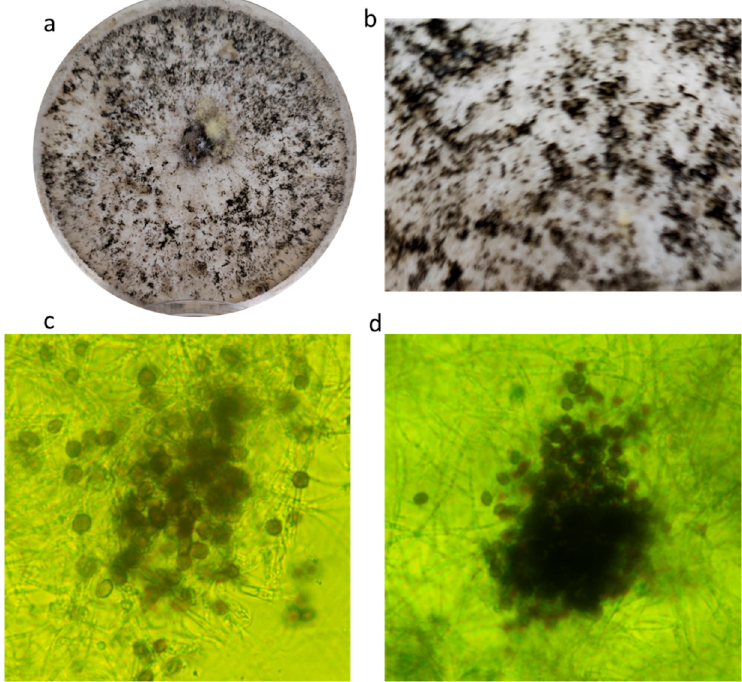
Figure 1 . Morphology of A. arundinis CREA OF 1128.1: ( a ) colony on PDA; ( b ) details of black structures; ( c ) conidia of CREA OF 1128.1; ( d ) conidiogenous cells giving rise to conidia. The ITS1 and β -tubulin partial sequences (OQ132873 and OQ249627) allowed us to identify the strain as Apiospora arundinis (Corda) Pintos & P. Alvarado. The sequences (Table 2) were aligned using the BLASTn tool in the GenBank database, and the results showed a 98.39% identity with A. arundinis isolate F4P4Fg (OM959567) in the ITS locus and an identity of 99.40% with the strain MUCL1684 (AB220322) for the β -tubulin se- quence, confirming that the strain CREA OF 1128.1 is A. arundinis (homotopic synonym: Arthrinium arundinis ) [33]. The pathogenicity tests validated Koch’s postulates, since the